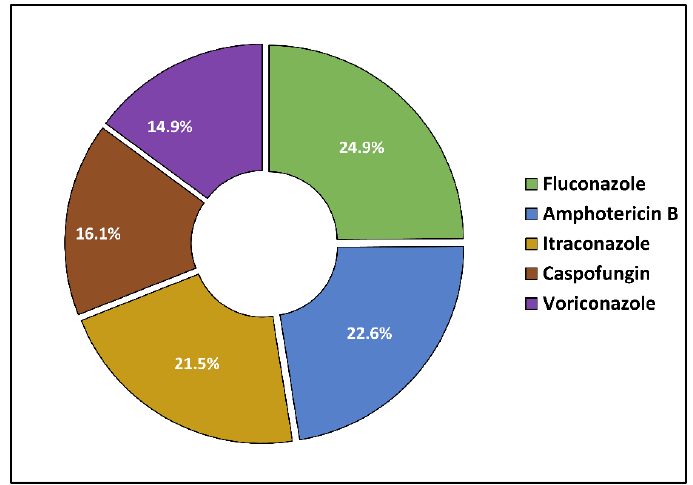
Figure 2. Distribution of antifungals used among patients with endocarditis. Data are represented as a pie chart of the five antifungals used in the affected patients in descending order of frequency of use.